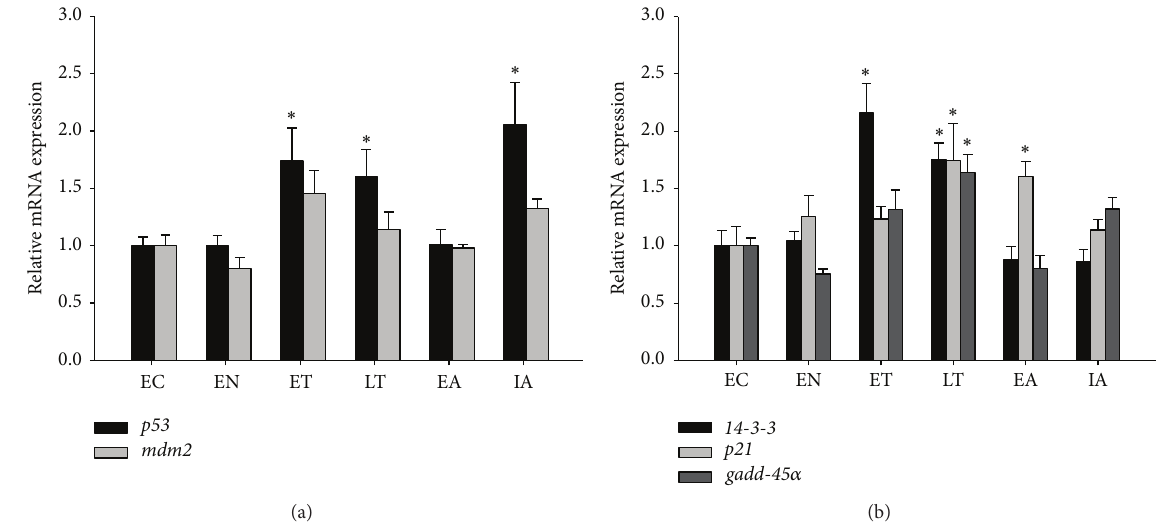
Figure 4: Transcriptional regulation of p53 in the hibernation cycle. Transcript levels of (a) p53 , mdm2, and (b) p53 downstream targets 14-3-3 𝜎 , p21 , and gadd-45 𝛼 are shown in the ground squirrel skeletal muscle over six stages of the hibernation cycle. Transcript levels were normalized to the housekeeping gene 𝛼 -tubulin . Data show means ± SEM, 𝑁 = 4 -5 independent trials on tissues from different animals. ∗ denotes significant statistical difference from EC values, 𝑝 < 0.05